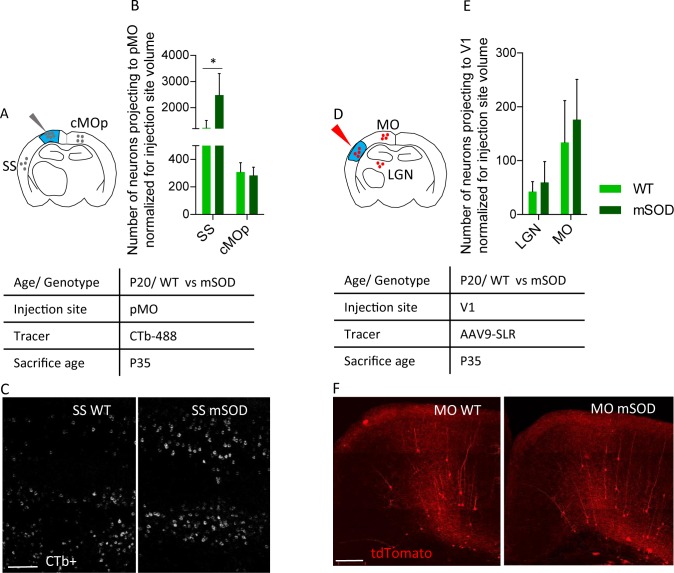
Increased projections to primary motor cortex in mSOD at pre-symptomatic stage (P20) is specific for motor network and is confirmed via the retrograde tracer choleratoxin.(A) Experimental design depicting injection site in pMO via choleratoxin (CTb) with two regions that have been investigated for retrograde infection (SS and cMOp). (B) Normalized (for injection site volume) number of neurons projecting to primary motor cortex, WT (N = 3) vs mSOD (N = 3), via Choleratoxin-b injection. CTb + retrogradely labeled projections from SS and cMOp to pMO. Increased projections from SS to pMO was again detected in mSOD (WT 1235 ± 280; mSOD 2487 ± 819, p=0.0156); projections from cMOp were comparable (WT 308 ± 67, mSOD 283 ± 59, p=0.9971), as in the virus tracing experiment. Detailed statistic provided in Supplementary file 2g. Display of total neuronal count in Figure 4—figure supplement 1A, detailed statistic for total neuronal count in Supplementary file 2f. (C) Representative images of SS from WT and mSOD, respectively, displaying CTb + neurons, scale bar 200 μm. (D) Experimental design depicting injection site in in primary visual cortex (V1) via AAV9-SLR with two regions that have been investigated for retrograde infection (LGN and MO). (E) Normalized (for injection site volume) number of neurons projecting to visual network (V1) from LGN (WT 42 ± 18 vs mSOD 60 ± 38; p=0.9263) and MO (WT 134 ± 77 vs SOD 176 ± 74, p=0.6360) in WT (N = 3) and mSOD (N = 3). No difference in projections from the two areas to V1 was found between WT vs mSOD. Detailed statistic provided in Supplementary file 2i. Display of total neuronal count in Figure 4—figure supplement 1B, detailed statistic in Supplementary file 2h. (F) Representative images of MO projection neurons to V1 in WT vs mSOD; scale bar 150 μm. Ordinary one-way ANOVA with Dunnett multiple comparison test.10.7554/eLife.36892.016Figure 4—source data 1.Total number of neurons projecting to primary motor cortex, WT vs mSOD via Choleratoxin-b injection.CTb + retrogradely labeled projections from SS and cMOp to pMO. Total number of neurons projecting to visual network (V1) from LGN and MO in WT and mSOD. Numbers expressed as total neuronal count and as normalized neuronal count for the volume of the injection site.